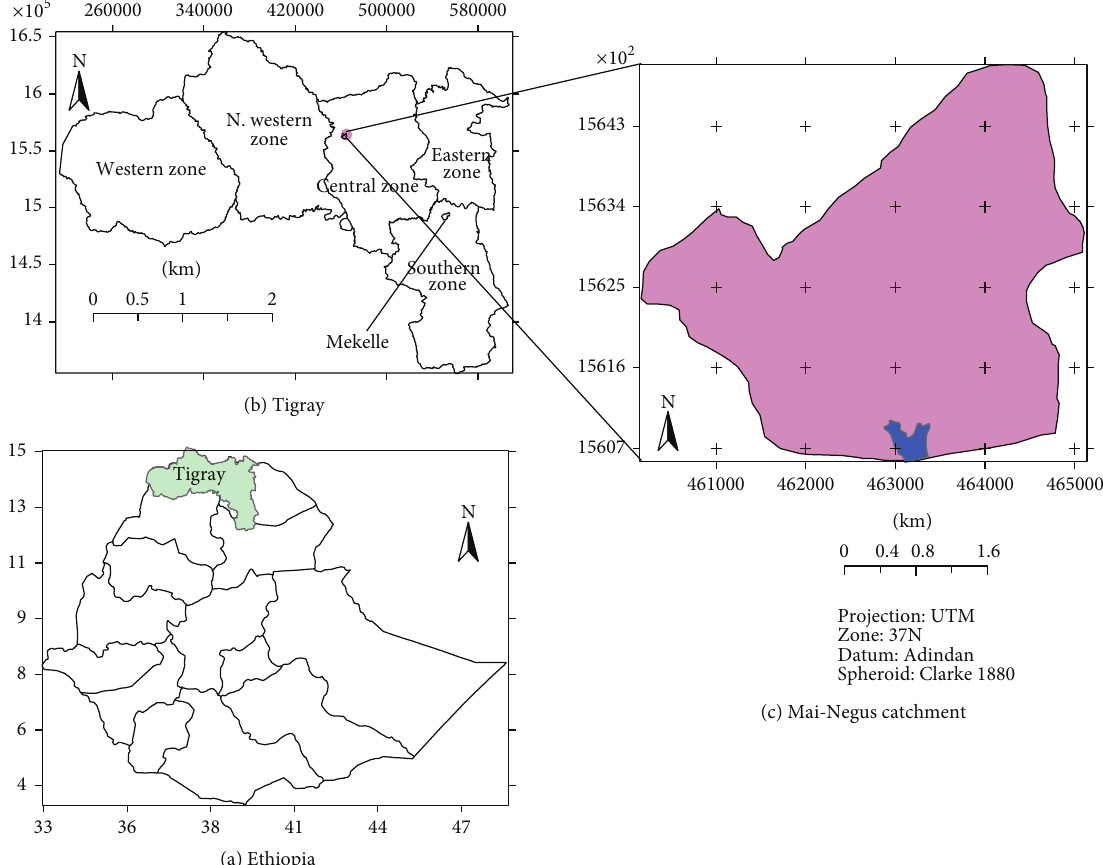
Figure 1: Study area: Ethiopia (a), Tigray (b), and Mai-Negus catchments (c). The blue colour shaded area is the reservoir.